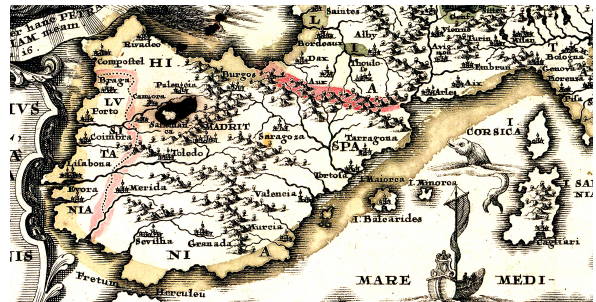
Figure 9: Unknown cartographer, c. 16th century, map of Roman Catholic states